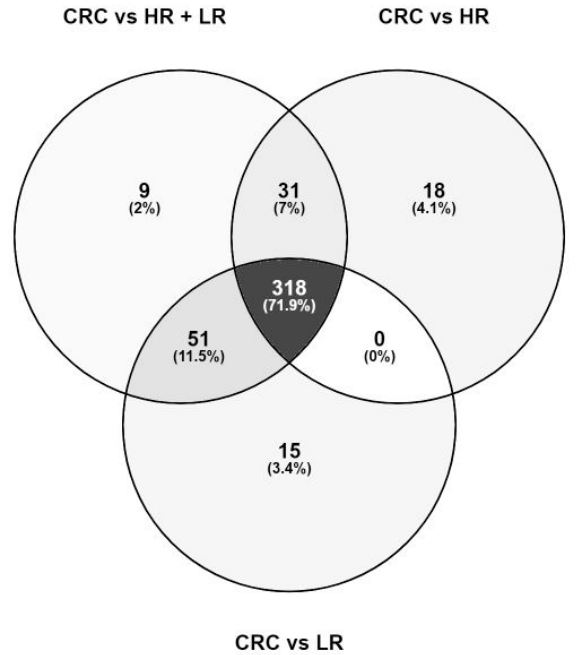
Figure 1. Venn diagram showing the overlap of 442 significant features detected in the three comparison groups. Nearly all metabolites were shared across the three comparison groups. A subset of metabolites was specifically detected within the CRC vs. HR and LR adenoma group (2%), CRC vs.